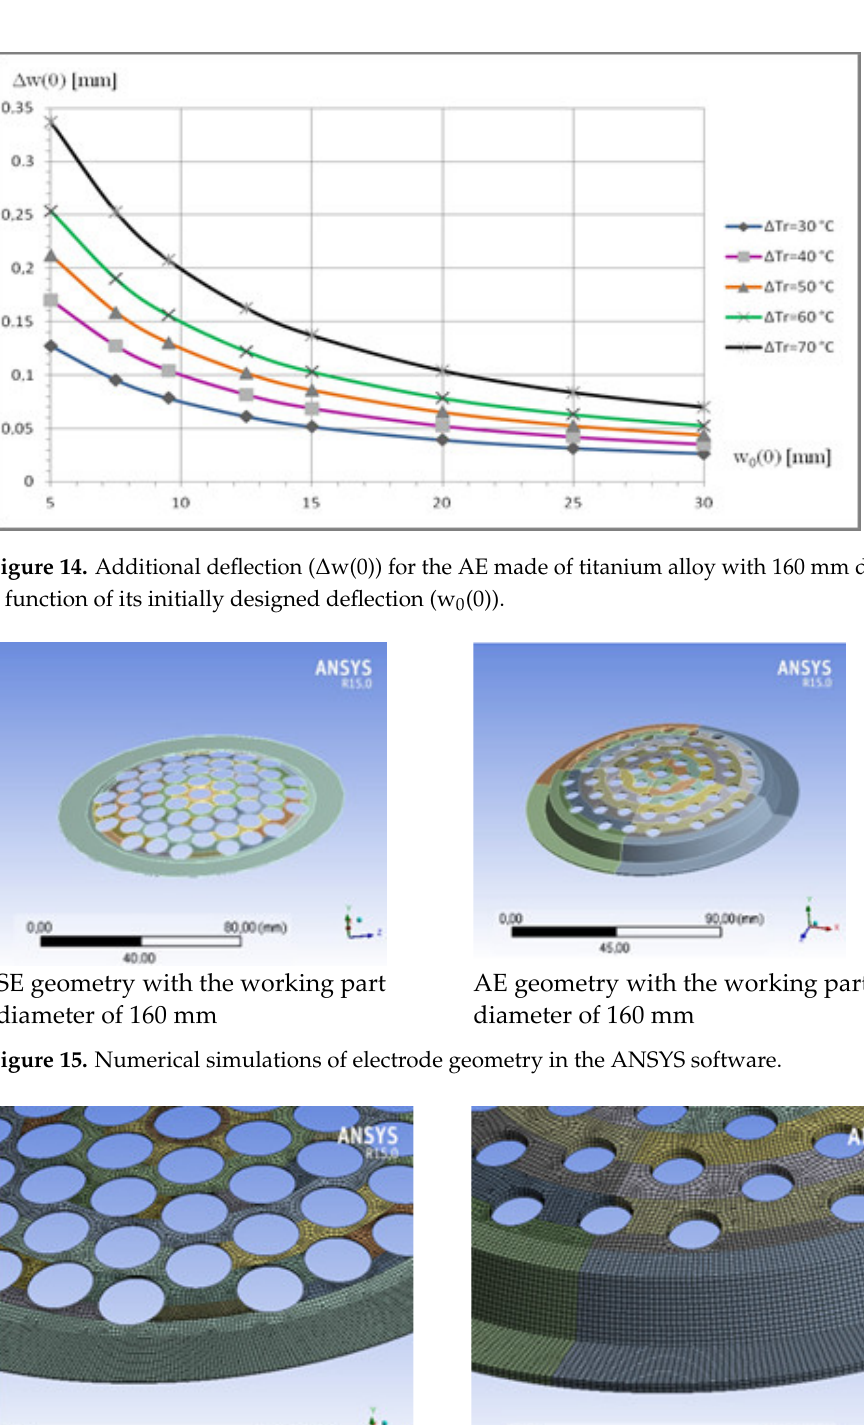
Figure 13. Additional deflection (∆w(0)) for the SE made of titanium alloy with 160 mm diameter as a function of its initially designed deflection (w 0 (0)).